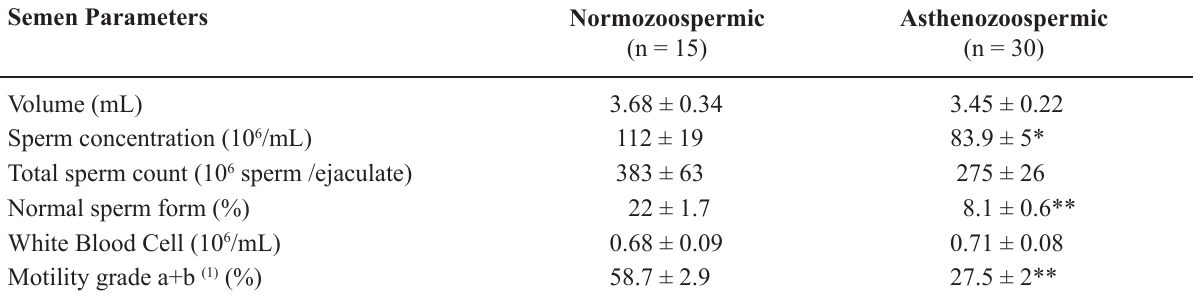
Table 1 – Basic semen parameters (mean ± SE) from normozoospermic and asthenozoospermic subjects.